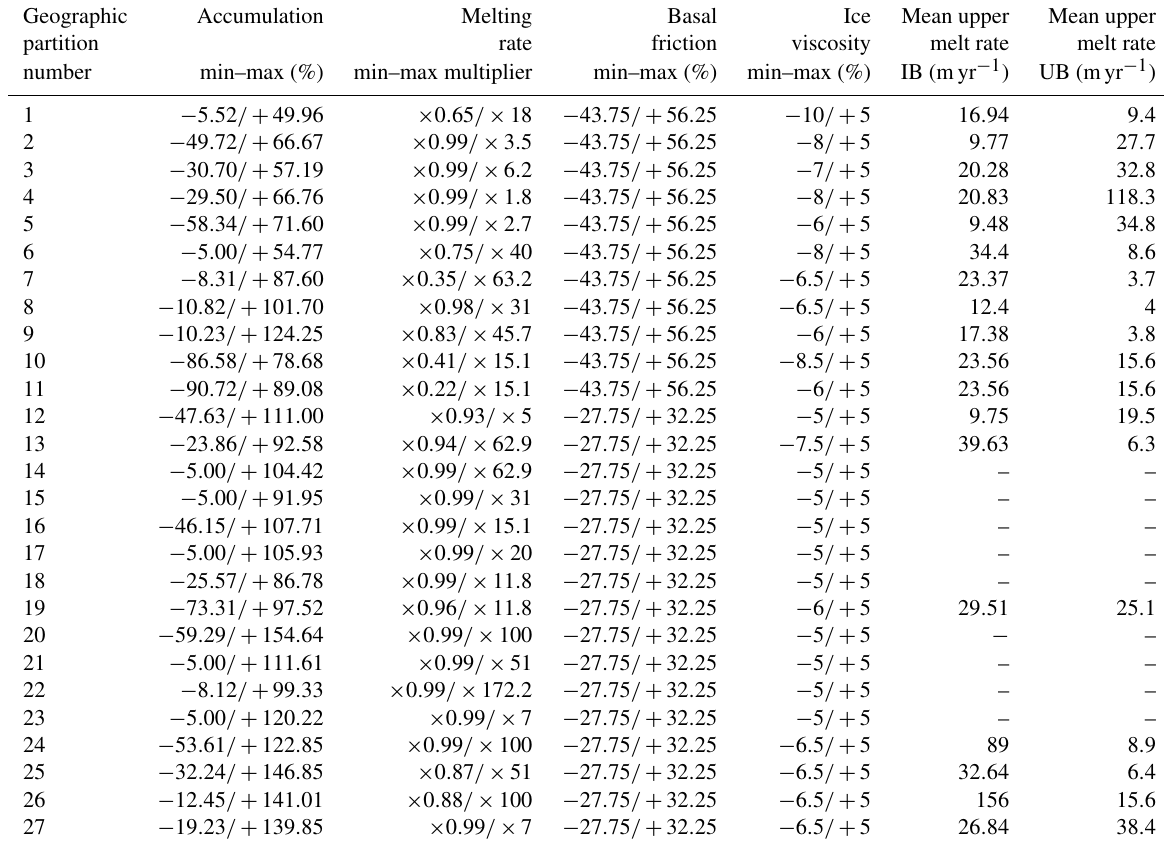
Table 2. For the IB experiments, the associated range of sampled variables for each GP is shown (Fig. 1). The last two columns list the mean upper-bound ice shelf melt rates forced for each marginal partition during the sampling experiments, for IB and UB. The mean upper-bound melt rate is equal to the maximum melt rate multiplier times the control ice shelf melt rate values, with area averaged over the initialization ice shelf area within each margin